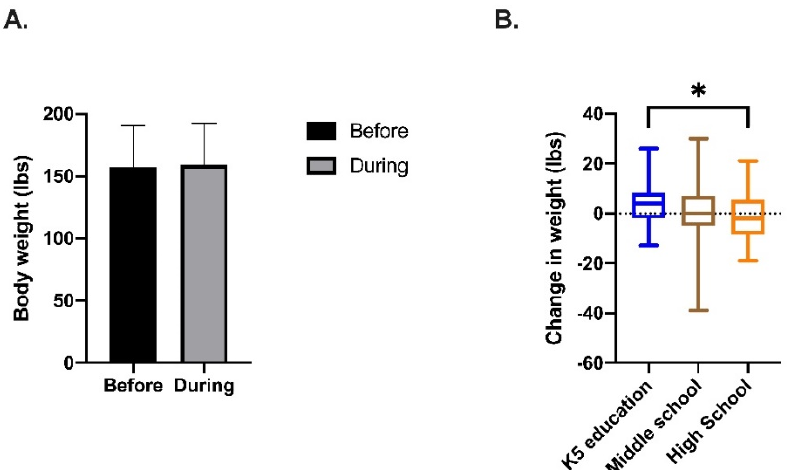
Figure 1. Body weight change (in pounds) for all participants ( A ) and separated by grade taught ( B ). ( A ) reports the mean and standard deviation of body weight for participants before and during the school closures. ( B ) reports Median and IQR. Kruskal-Wallis rank-sum tests were used to determine significance. * indicates p value <